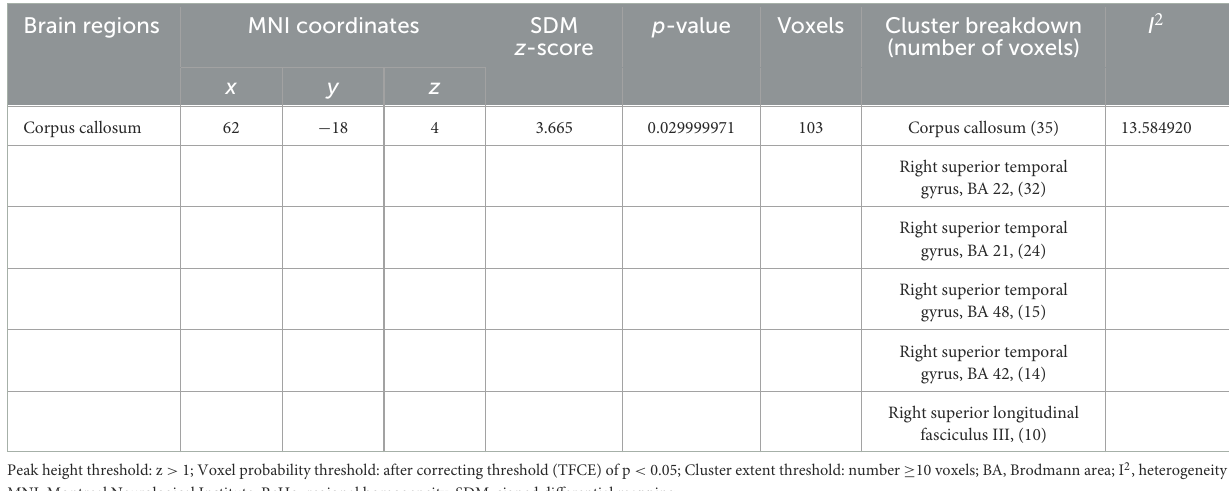
TABLE 4 Brain activity changes in migraine patients vs. healthy controls in a coordinate-based meta-analysis.